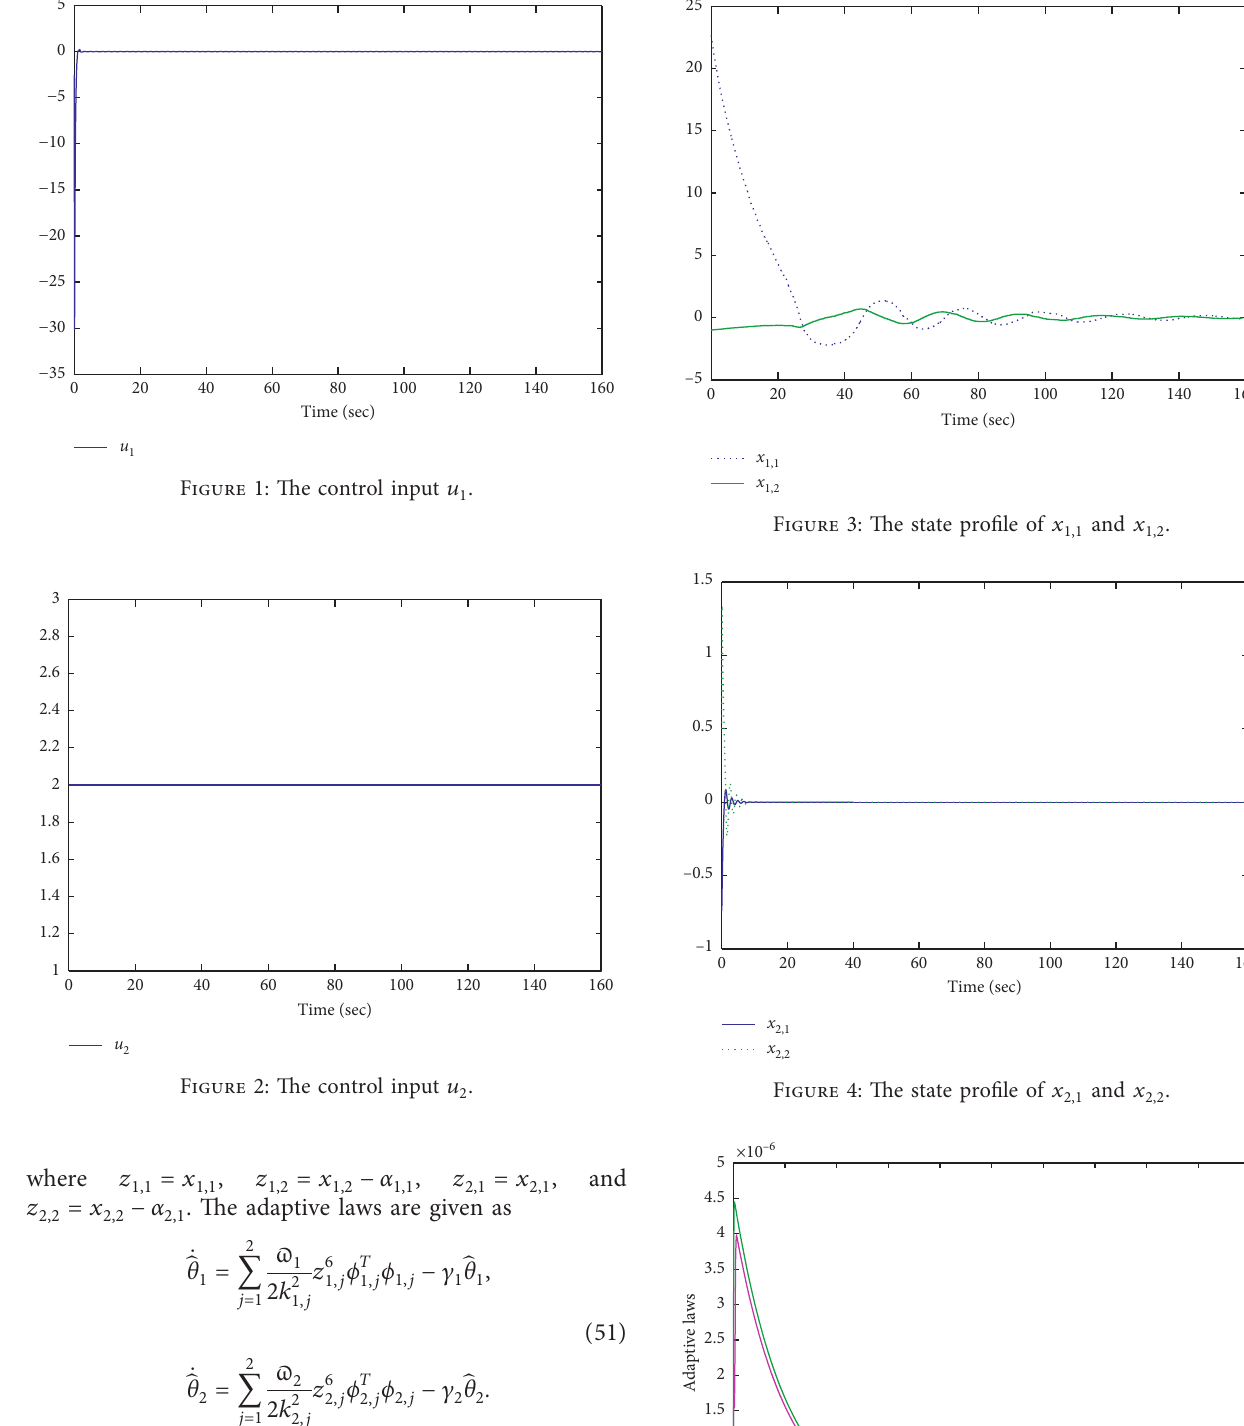
Figure 5: The time profile of 􏽢 θ